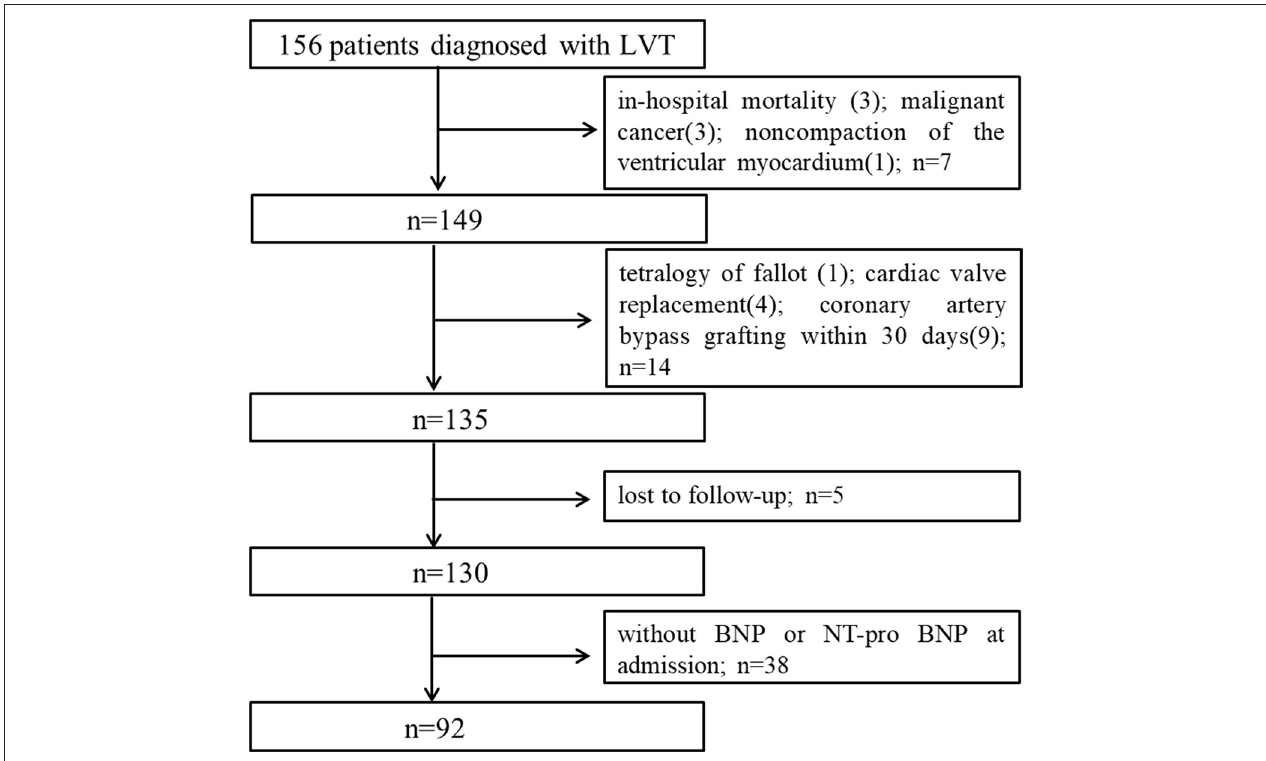
FIGURE 1 | Study flow chart of subjects enrollment. LVT, left ventricular thrombus; BNP, brain natriuretic